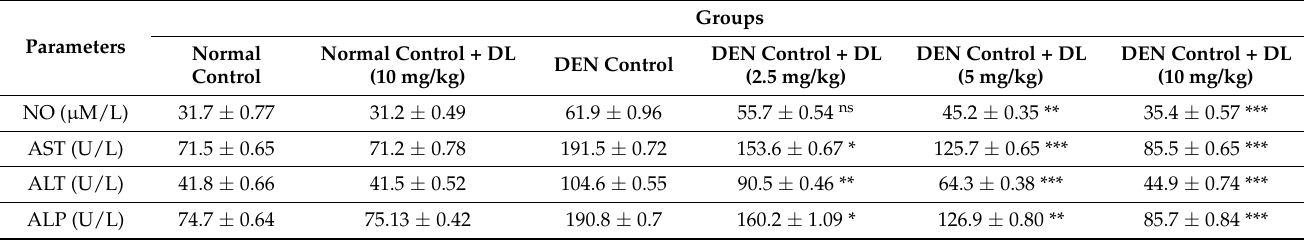
Table 2. Effect of DL on non-liver